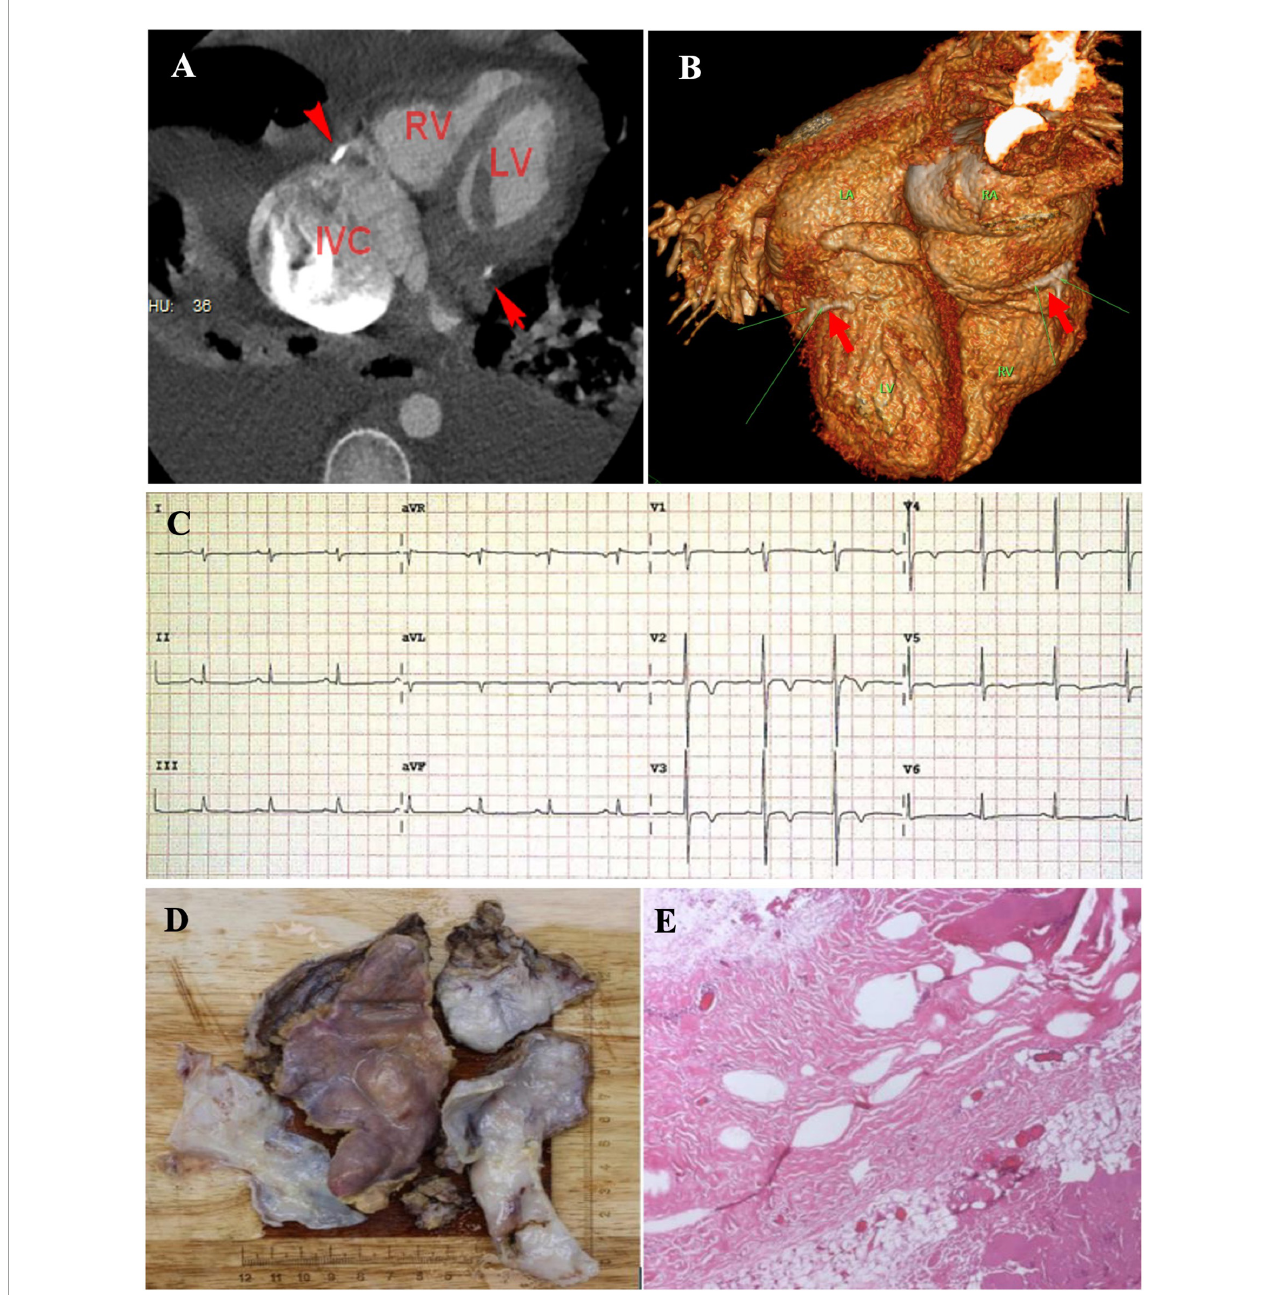
FIGURE3 Cardiac computed tomographic angiogram of four-chamber view (A) and volume rendering views (B) showed calcified annular constrictive pericarditis (ACP) trapping both ventricles (red arrows). Spontaneous conversion from atrial fibrillation (AF) to sinus rhythm as the calcified pericardial ring was severed (C) . Complete pericardiectomy was performed and revealed a thickened pericardium with calcification embedded in the atrioventricular (AV) groove (D) . Pathological examination of the pericardial tissue indicated fibrotic tissue with calcification (E)